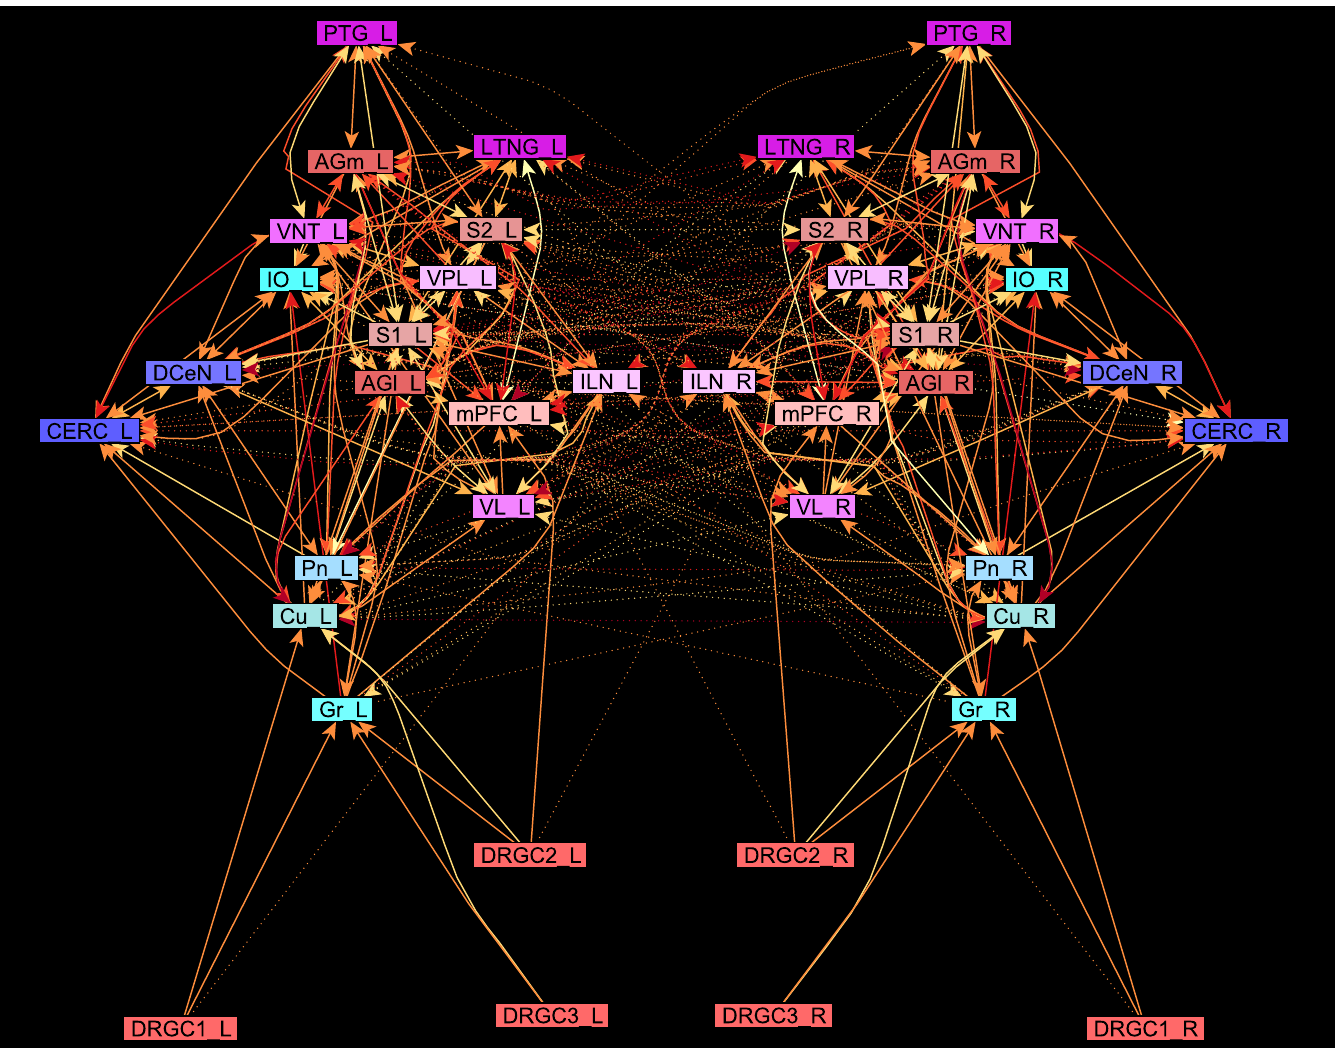
Fig 2. The weighted digraph of the bilateral mechanosensory subconnectome. The bilateral weighted digraph of the adjacency matrix shown in Fig 1. The dashed lines indicate contralateral projections.